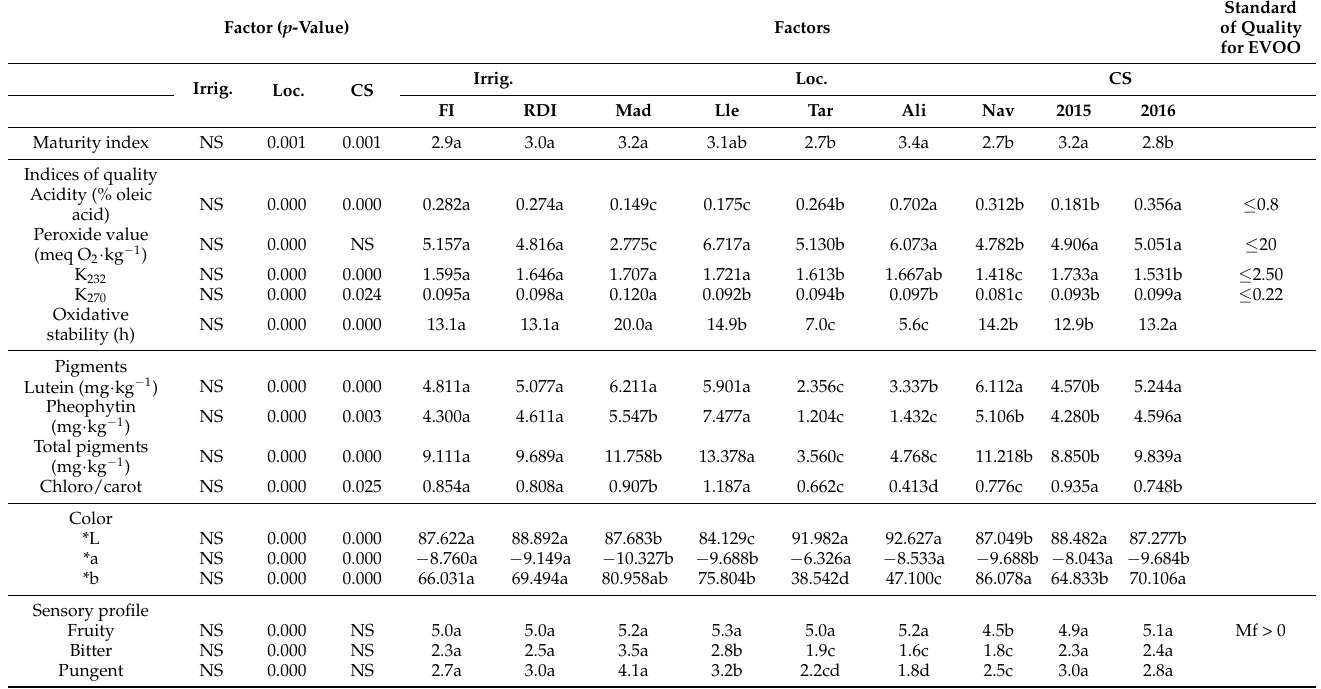
Table 2. Three-way ANOVA (prob > F) and least square means of the maturity index, olive oil quality parameters, and sensory profile for the different factors: irrigation (Irrig: full irrigation: FI; regulated- deficit irrigation: RDI); location (Loc.: Mad: Madrid, Lle: Lleida, Tar: Tarragona, Ali: Alicante, and Nav: Navarra); and crop seasons (CS: 2015 and 2016). Standard Factors of Quality for